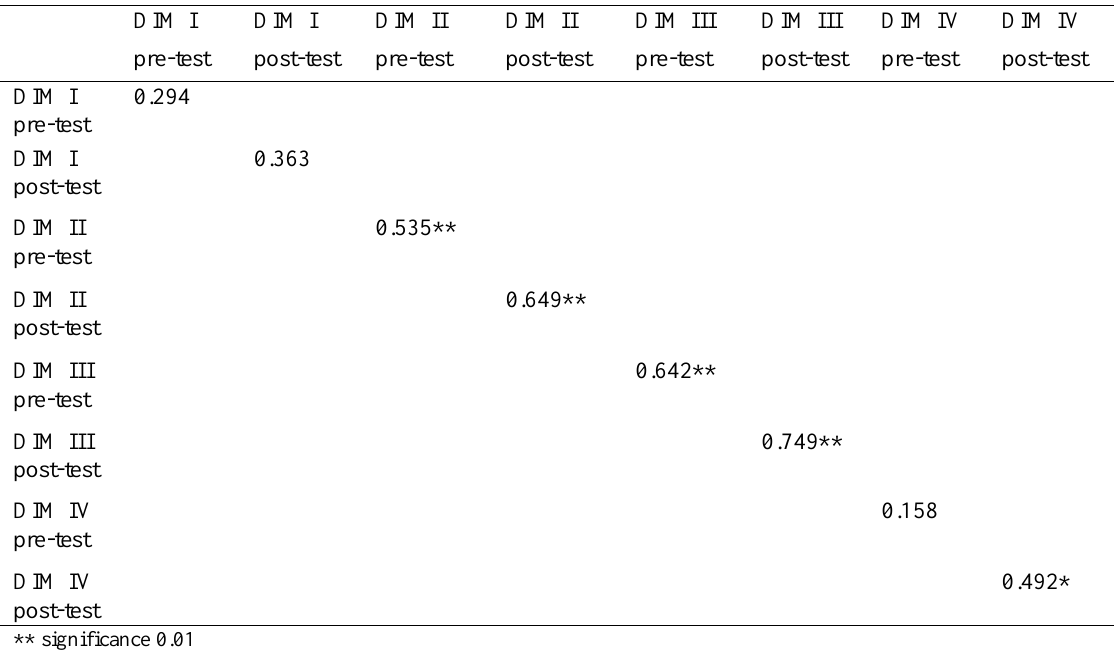
Table 2. IG's Spearman correlation values for positive and negative questions for pre- and post-tests.